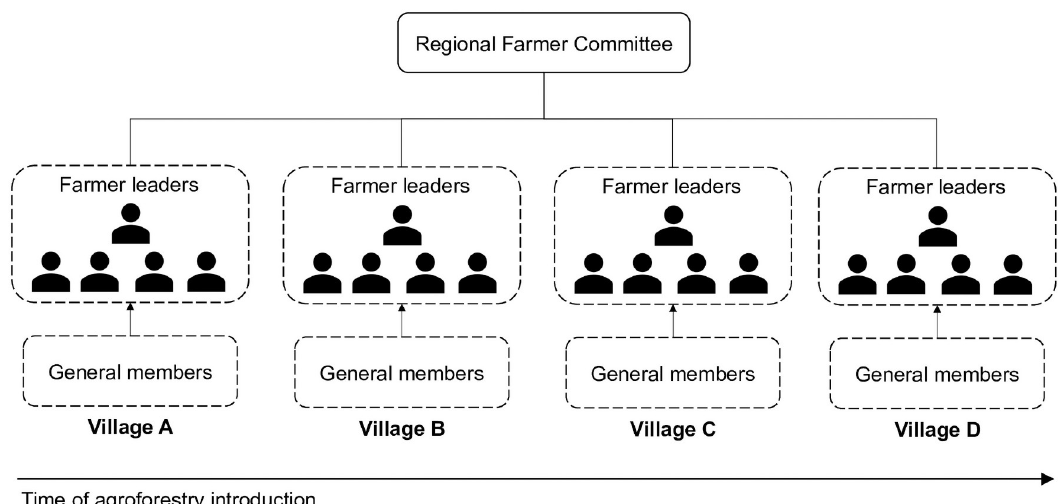
Fig 1. Organizational structure of Thone Yaung Che. Farmers elected into leadership positions, including the administrative leaders, are ‘farmer leaders’ represented by the person icons and farmers outside these positions are ‘general members.’ Villages are ordered by the time of agroforestry introduction, indicated by the